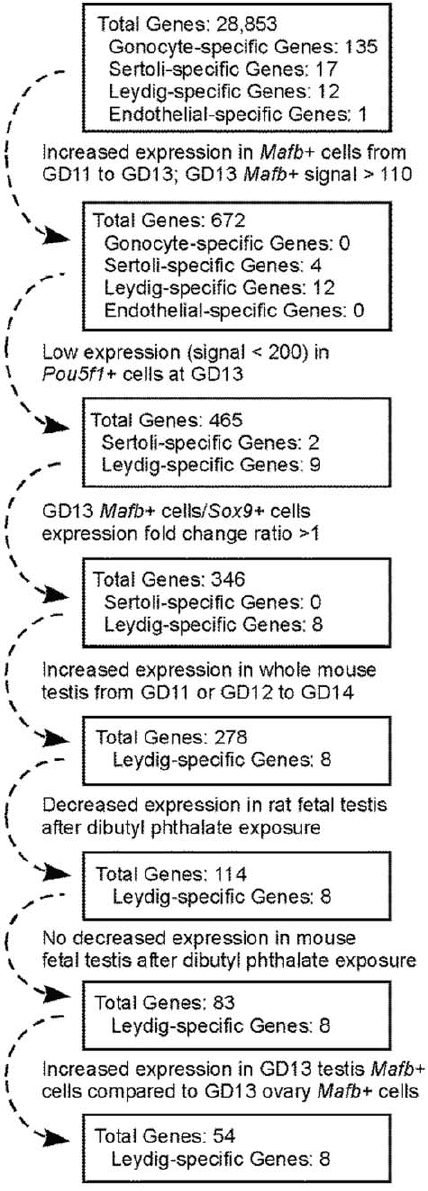
Figure 1. Flowchart showing the steps used to generate the fetal Leydig cell-specific candidate gene list. A detailed explana- tion of this multistep, sequential process is found in the first worksheet of File S1. In step 1, genes were retained that displayed a signal . 110 in GD13 testis Mafb -positive cells and an increased expression along with a FDR-corrected p-value , 0.25 when comparing GD13 testis Mafb - positive cells to GD11 testis Mafb -positive cells. In step 2, genes were discarded showing an expression signal . 200 in GD13 testis Pou5f1 - positive cells. In step 3, genes were culled that had higher expression (expression ratio . 1) in GD13 testis Sox9 -positive cells compared to GD13 testis Mafb -positive cells. In step 4, genes were retained that showed an increased expression (expression ratio . 1) and a FDR- corrected p-value , 0.25 when comparing GD11 or GD12 to GD14 whole mouse testis. In step 5, genes were retained showing a decrease in gene expression (expression ratio , 1) and a FDR-corrected p-value , 0.25 after rat DBP exposure. In step 6, genes were culled that displayed reduced expression (expression ratio , 1) and a FDR- corrected p-value , 0.25 after mouse DBP exposure. In step 7, genes were retained that showed an increase in expression (expression ratio . 1) and a FDR-corrected p-value , 0.25 in GD13 testis Mafb -positive cells compared to GD13 ovary Mafb -positive cells. doi:10.1371/journal.pone.0047359.g001 PLOS ONE |